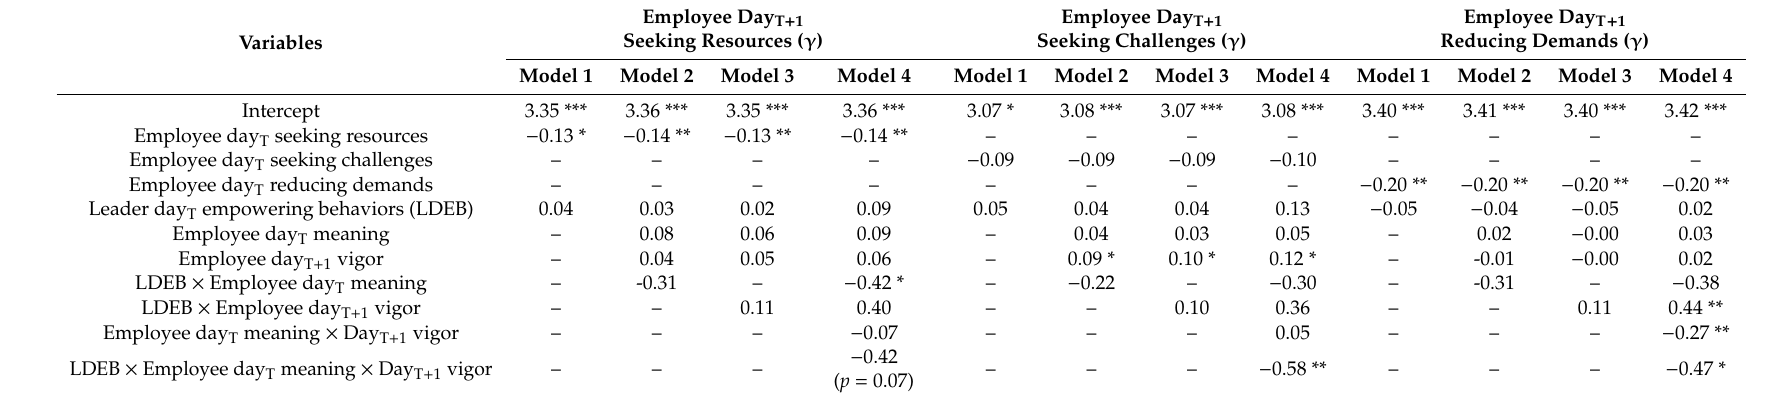
Table 2. The multilevel regression models for testing the